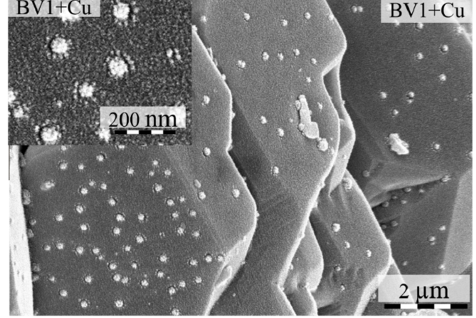
Figure 6. The Cu nanoparticles deposited on the surface of sample BV1.